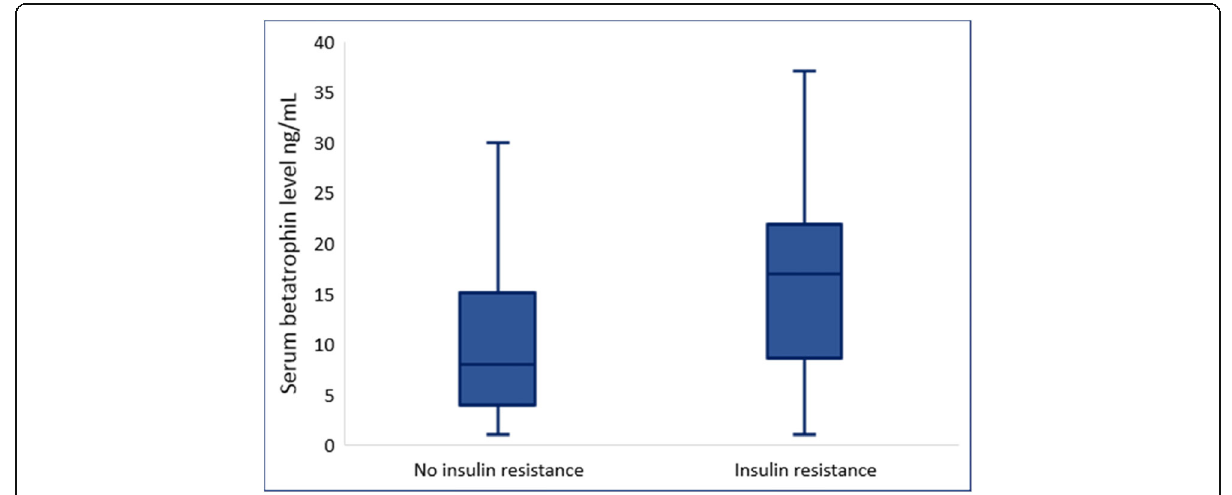
Fig. 1 Box plot showing serum betatrophin levels in subjects with and without insulin resistance